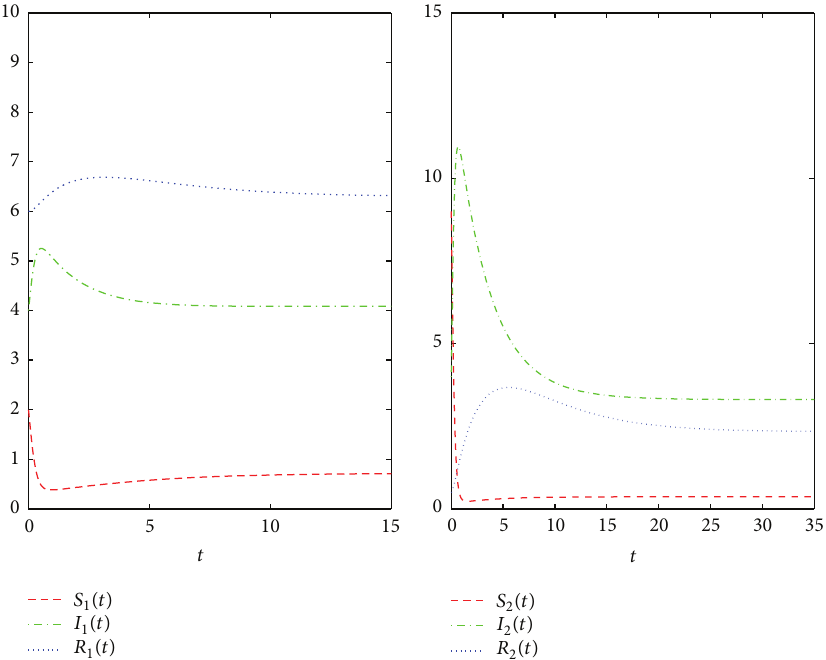
Figure 1: Deterministic trajectories of SIRS model (1) for initial condition 𝑆 1 (0) = 2 , 𝐼 1 (0) = 4 , 𝑅 1 (0) = 6 , 𝑆 2 (0) = 9 , 𝐼 2 (0) = 4 , and 𝑅 2 (0) = 0.5 .